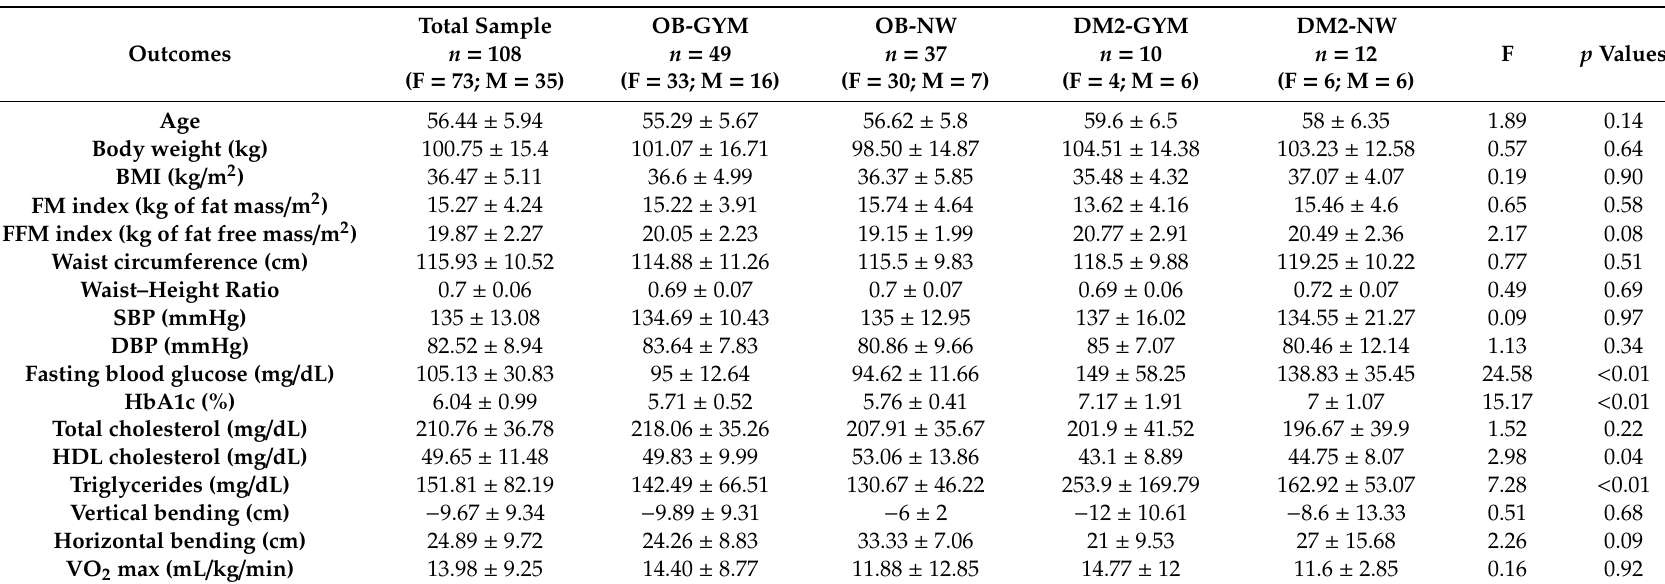
Table 1. Anthropometric, blood pressure, blood chemistry, and fitness parameters at baseline . Baseline values: Mean values of anthropometric, blood pressure and blood chemistry parameters in the entire sample and in the 4 subgroups. Data are presented as means ± SDs. Statistical significance was set for p values ≤